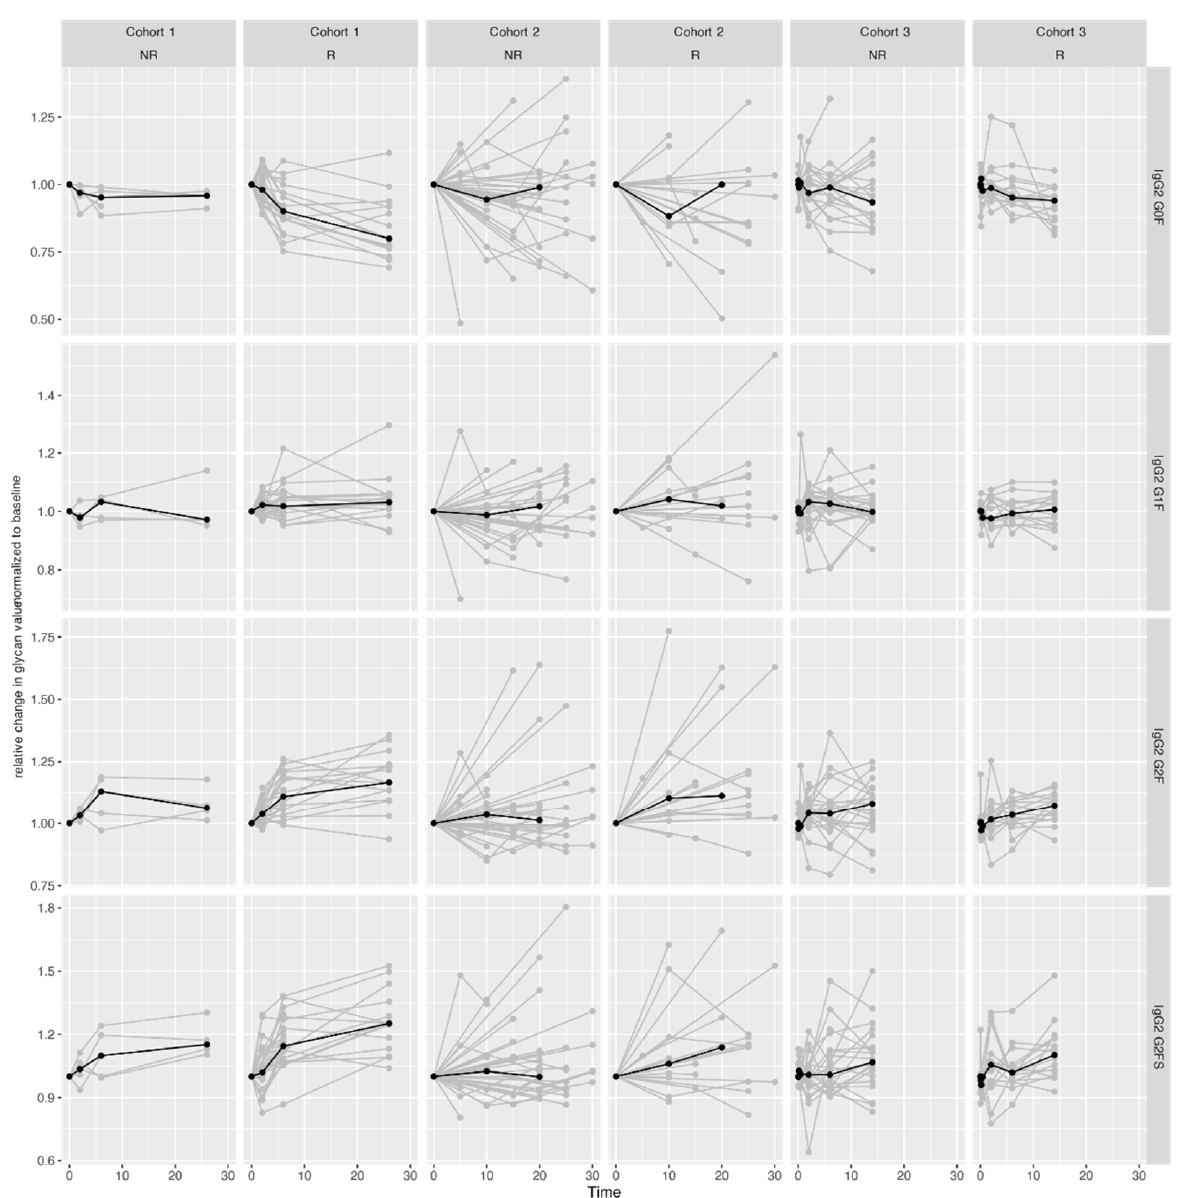
Figure 3. Changes in IgG2/3 Fc glycan profiles during treatment in CID (UC and CD) patients that entered remission (R) vs. patients with active disease (NR) in three cohorts. Median glycan values for each time point are bolded. Y-axis: relative change in glycan value normalized to baseline (1st timepoint); X-axis: duration of follow-up (weeks). Associations of IgG Fc glycan profiles with disease activity during treatment, for each patient cohort separately, are shown in Table S9, while the results of meta-analysis of all three cohorts are presented in Table 2.